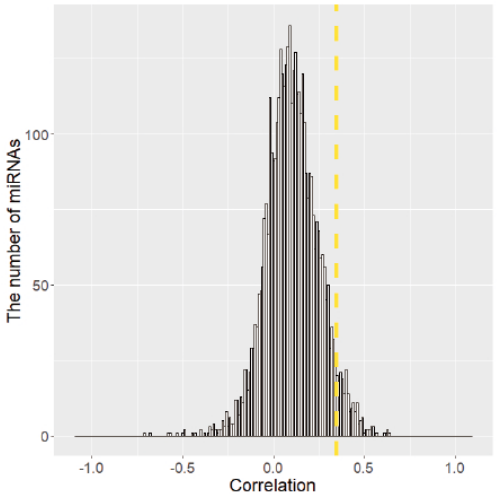
Figure 2. Relationship between copy numbers and miRNA expression. Pearson correlation coefficients (PCCs) showing the correlation between copy numbers and miRNA expression levels. Yellow dashed line, PCC